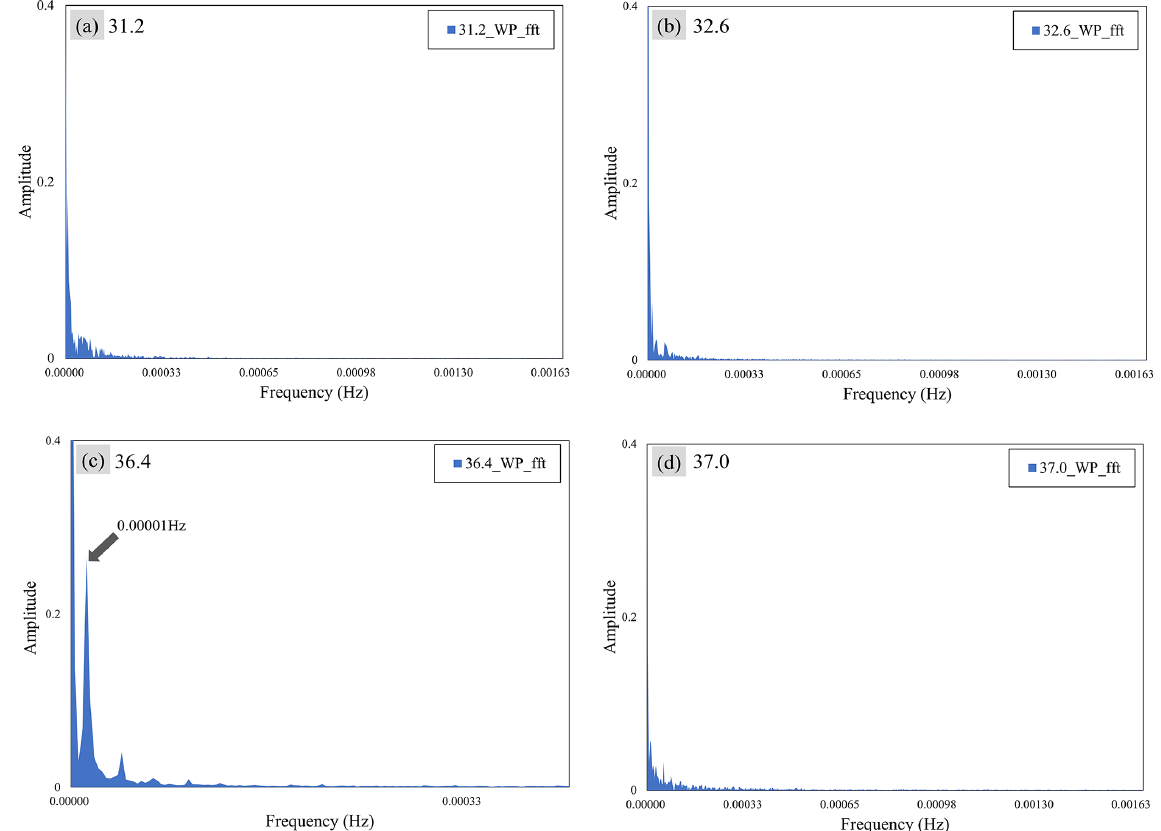
Figure 12. Fast Fourier transform of the result of the data signal of the water pressure sensor. Panels (a), (b), and (d) indicate points where the system dynamics model predicted that black ice would occur, and no waveforms of a particular period were observed. Panel (c) indicates the point where the system dynamics model predicted that black ice did not occur, and a waveform of a particular period was